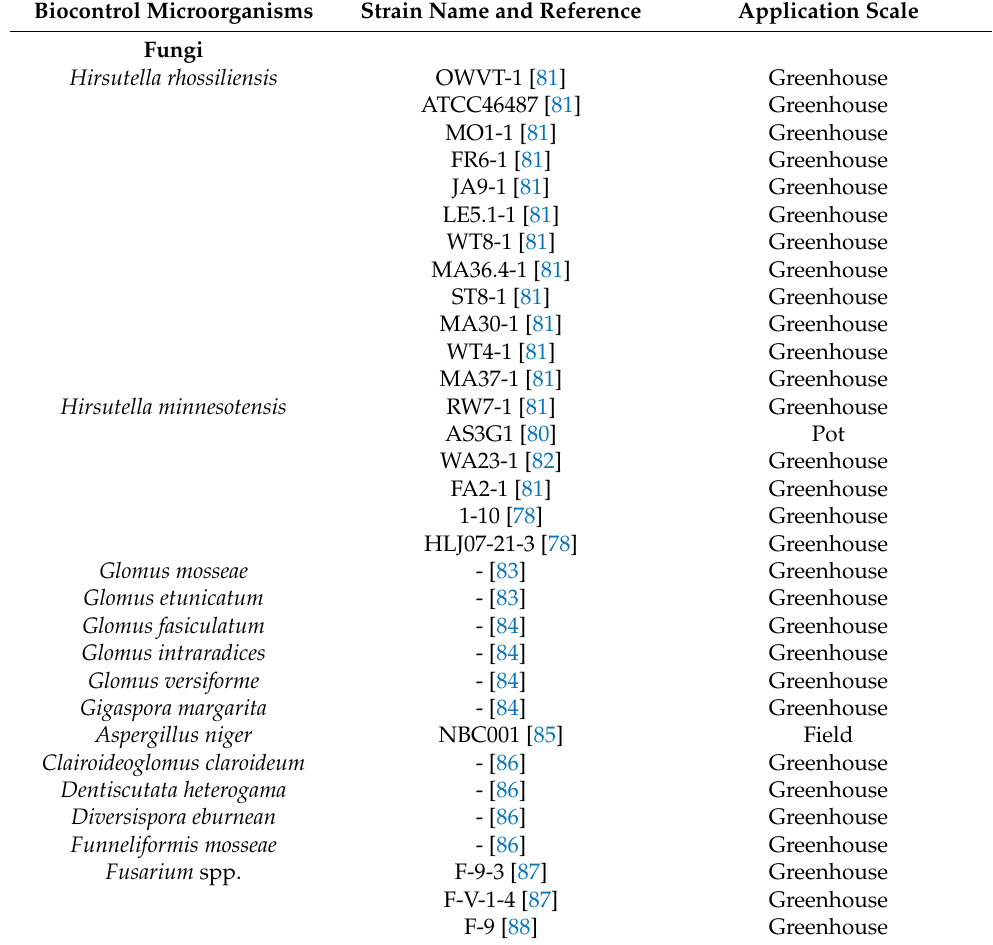
Table 3. Overview of biocontrol agents showing control ability against